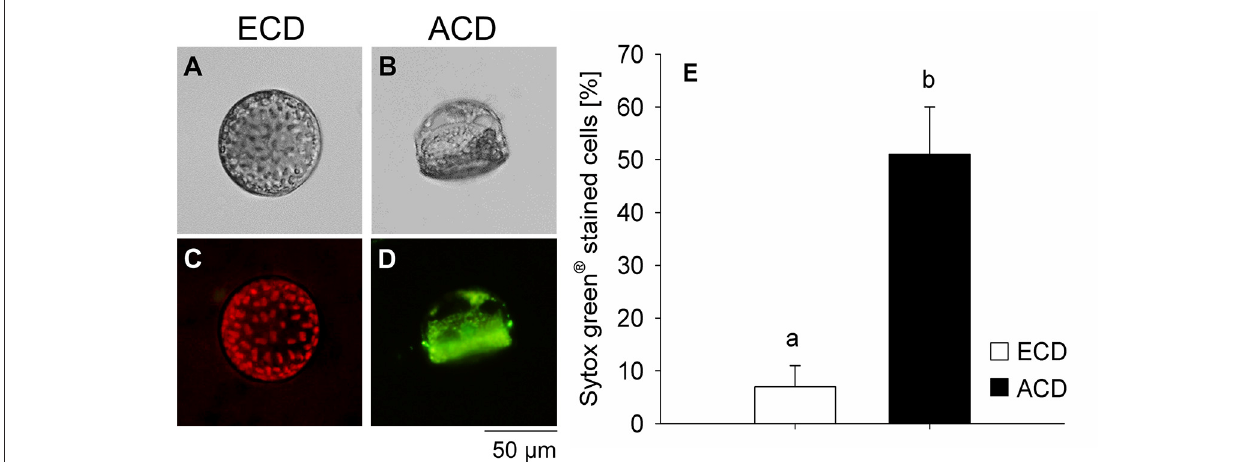
FIGURE 7 | Lethality test using Sytox ® green staining on Coscinodiscus granii cells with an even chloroplast distribution (ECD) (A,C) or an altered chloroplast distribution (ACD) (B,D). (E) Proportion of cells that were positively tested on lethality. (C) Cells with an ECD always showed a pronounced chlorophyll auto-fluorescence. Average values and standard error ( n = 3 ) are indicated. Statistically significant differences between the treatments are indicated as different small letters ( p < 0.05